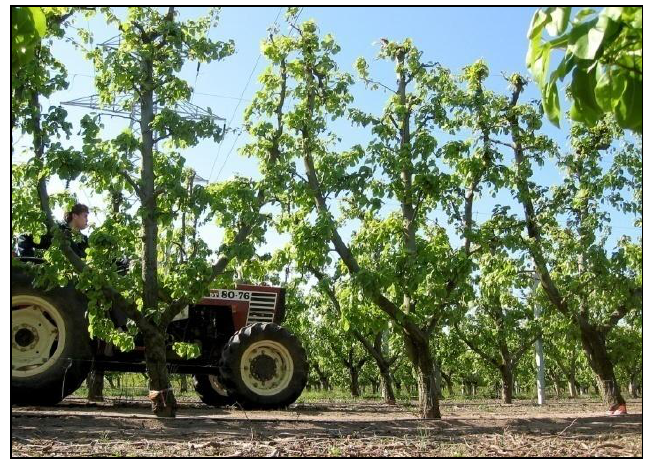
Figure 8. Photograph of Section 1 pear tree vegetation ( Pyrus communis L. cv Blanquilla), Lleida, Spain, April